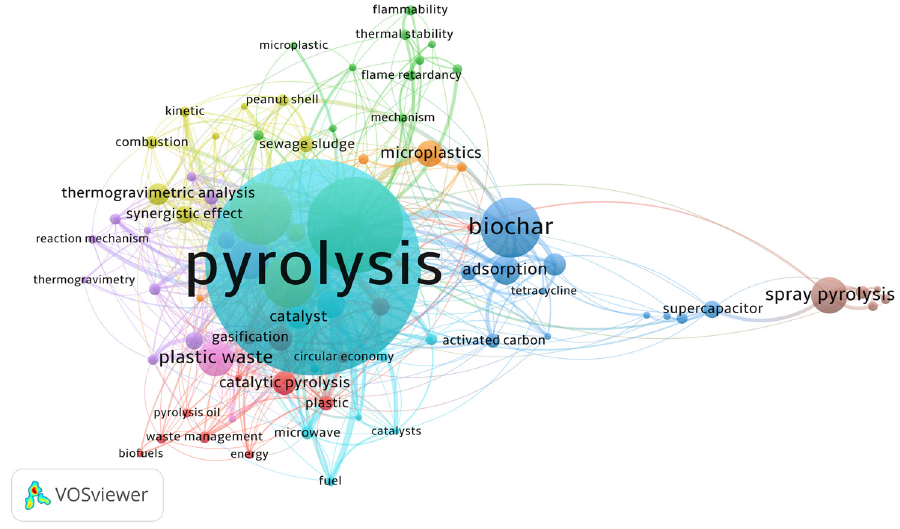
Figure 4. Co-occurrence of author keywords from PS thermo-catalytic pyrolysis research.